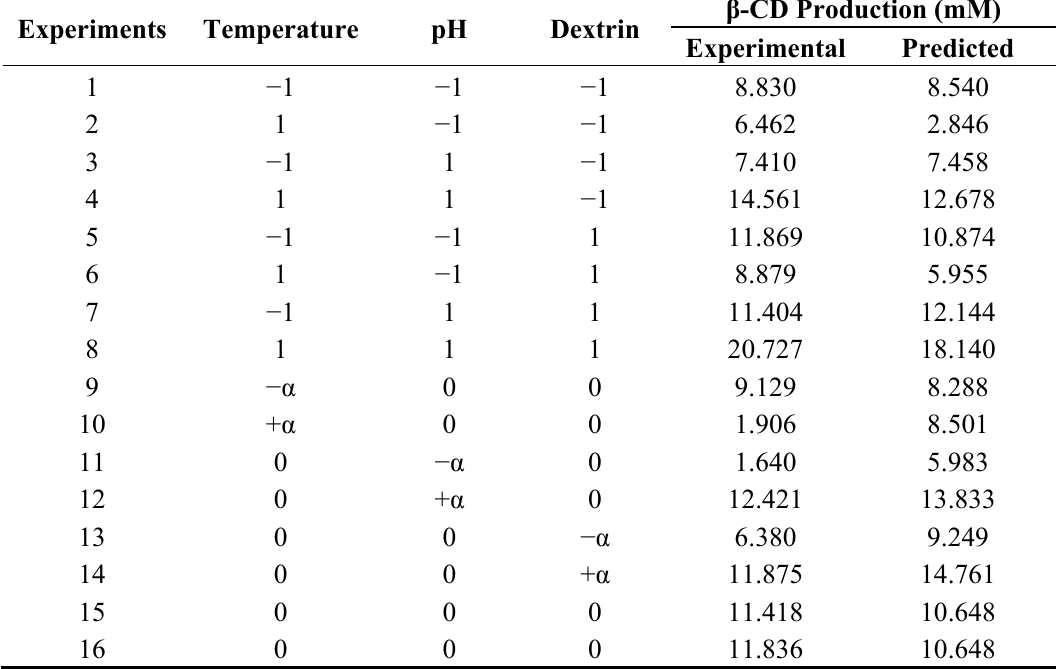
Table 1. Experimental design and results of CCD for the response surface methodology.